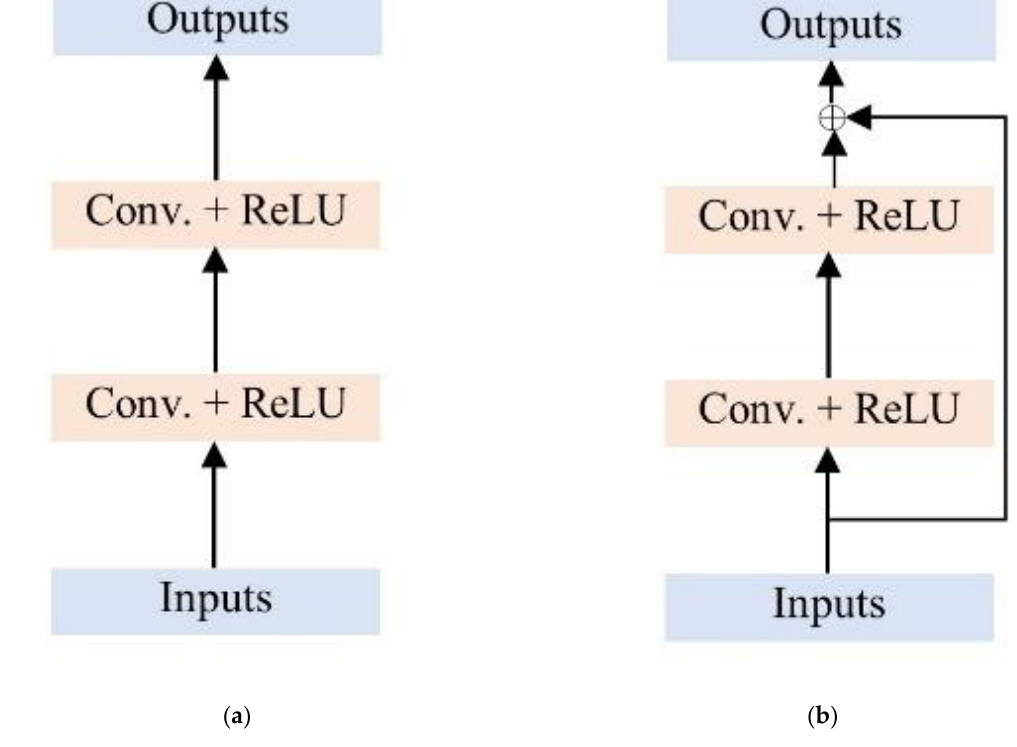
Figure 1. The fundamental structure of the convolutional neural network (CNN): ( a ) traditional CNN and ( b ) residual CNN.